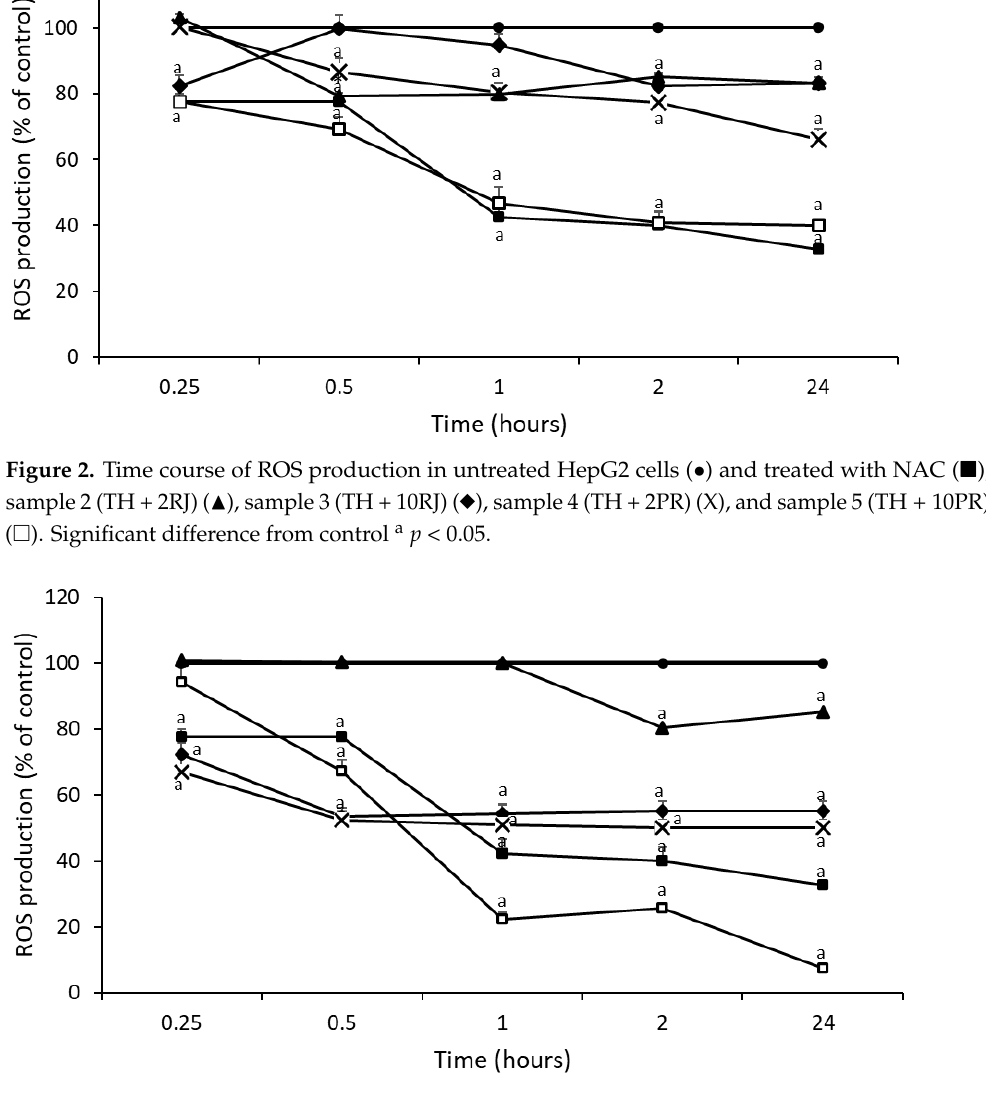
Figure 4. Time course of ROS production in untreated HepG2 cells ( ● ) and treated with NAC ( ■ ), sample 11 (TH + 2RJ + 2PR) ( ▲ ), sample 12 (TH + 10RJ + 10PR) ( ◆ ), sample 13 (CH + 2RJ + 2PR) (X), and sample 14 (CH + 10RJ + 10PR) ( □ ). Significant difference from control a p < 0.05. In summary, 16 of 17 samples studied in the present work reduced intracellular ROS production in HepG2 cells compared to untreated cells. Samples 14 (CH + 10RJ + 10PR) and 16 (PR) showed the best results, followed by sample 10 (CH + 10PR) and sample 5 (TH + 10PR). Supplementation of thyme and chestnut honey with 10% propolis had a greater effect on the decrease of ROS levels in HepG2 cells. Taking into account all of our results, samples with the highest phenolic content and overall antioxidant capacity (DPPH, ORAC, and ABTS) were in this order: samples 16